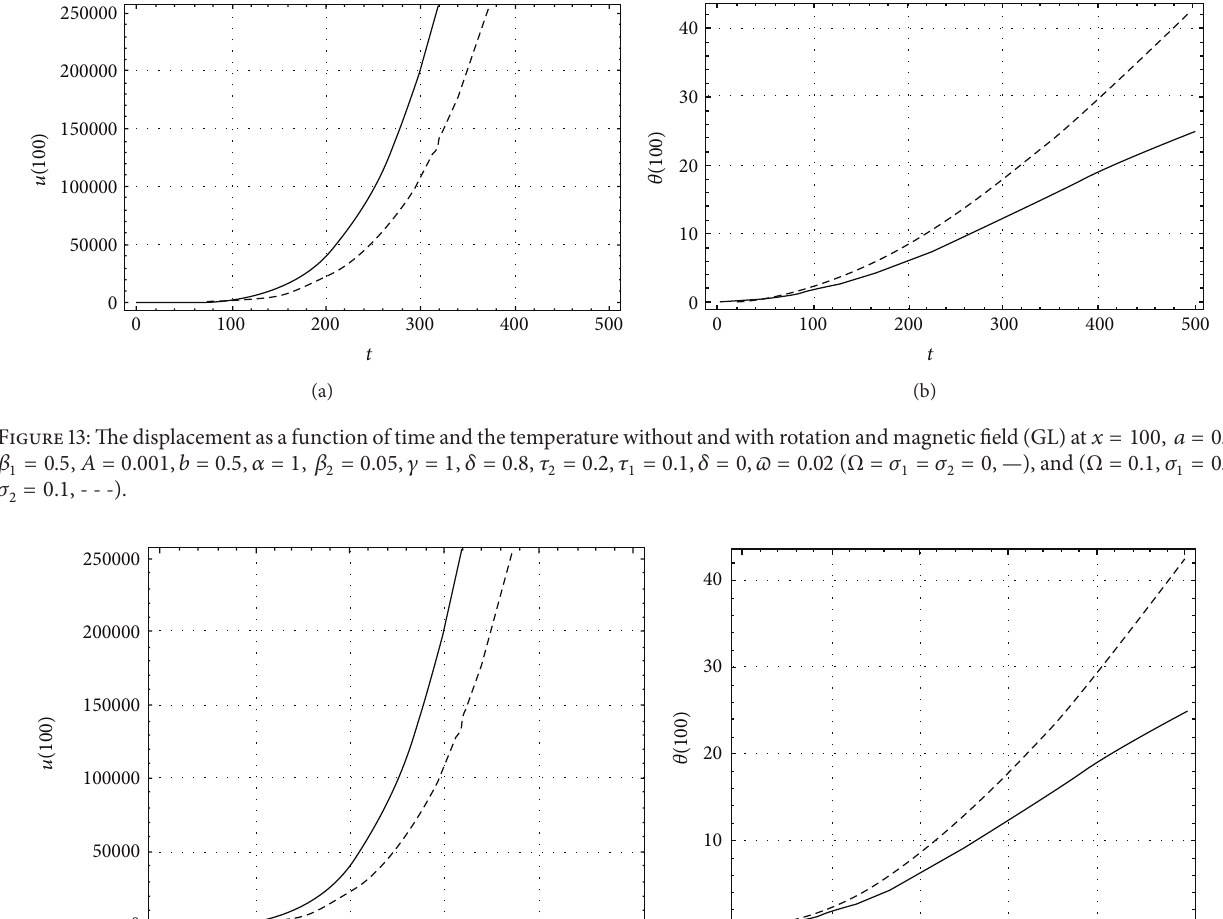
Figure 12: The displacement as a function of time and the temperature without and with rotation and magnetic field (LS) at 𝑥 = 100 , 𝑎 = 0.5 , = 0.5 , 𝐴 = 0.001 , 𝑏 = 0.5 , 𝛼 = 1 , 𝛽 𝛽 1 = 0.1 , - - -). 𝜎 2